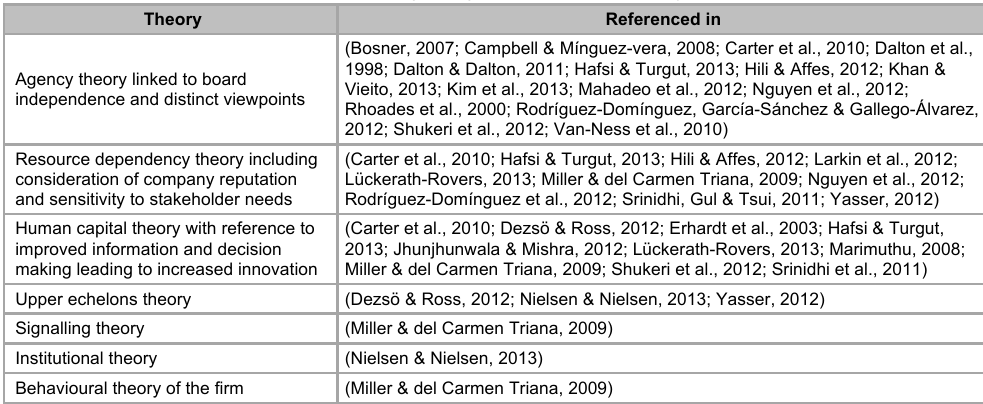
Table 2 Theories regarding the benefits of